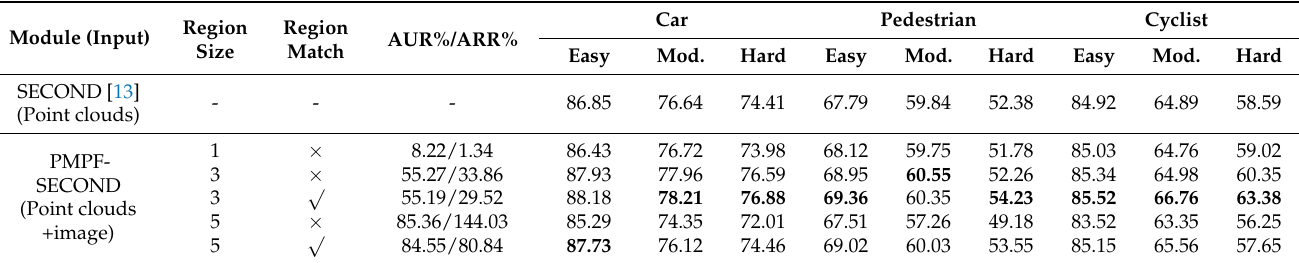
Table 6. An ablation study result for effect of PMPF components on SECOND on KITTI 3D object √ detection validation set. “ ” and “ × ” denote the results with or without the region match